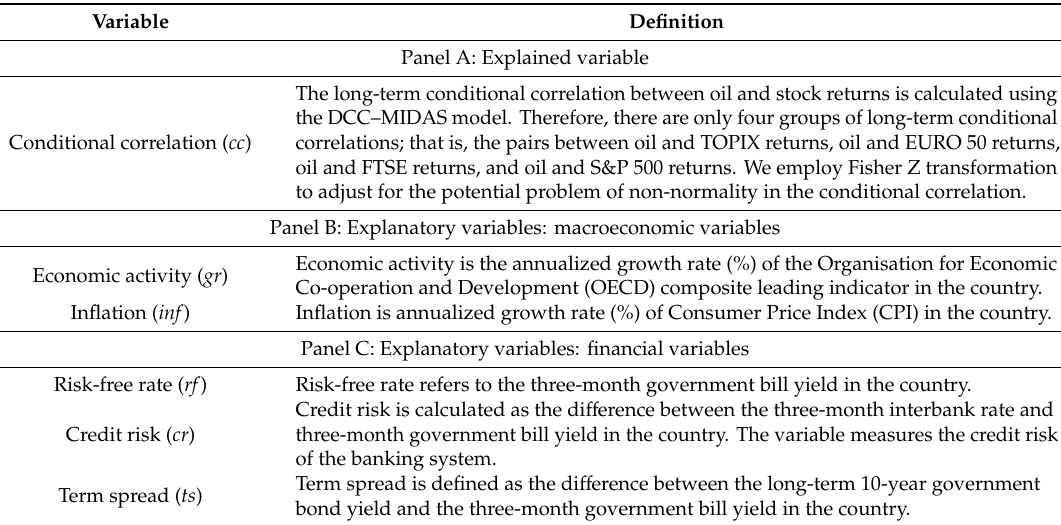
Table 5. Definition of variables.